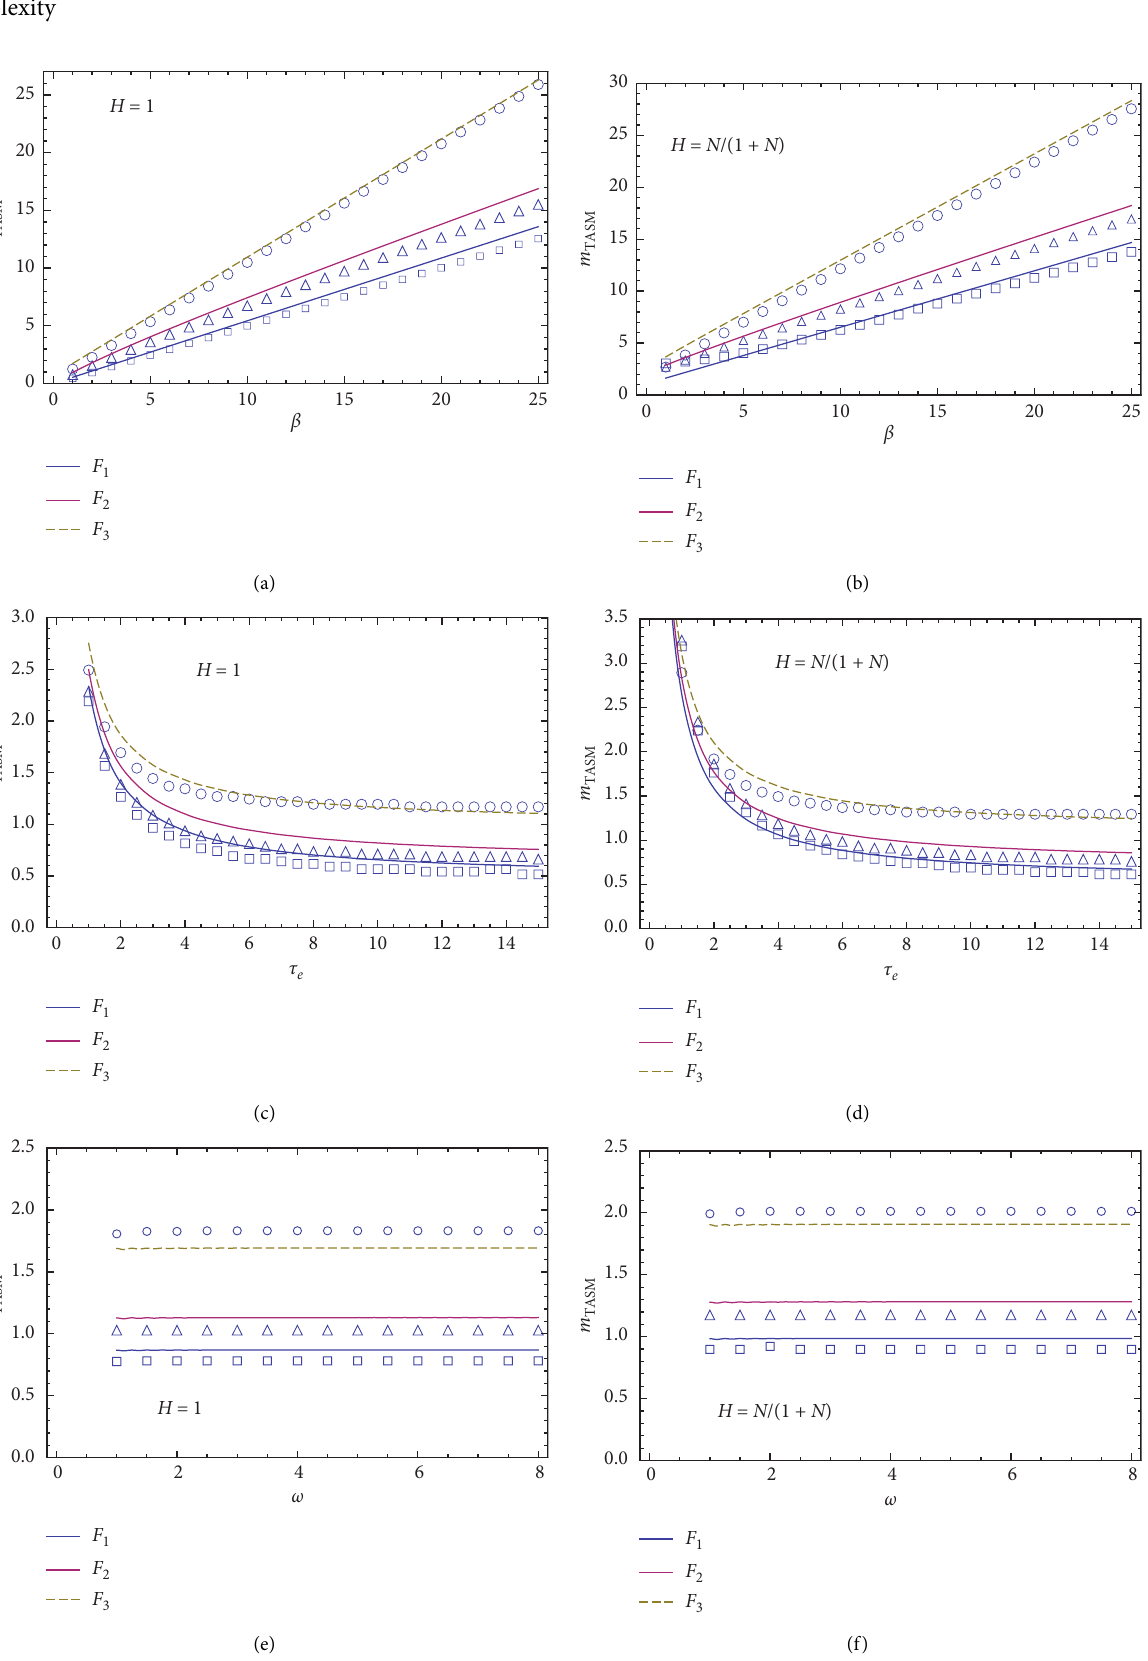
Figure 5: Theoretical and simulated m , in the case of periodic mass release strategy, as a function of β , as a function of τ e , and as a TASM function of ω . Parameters values are r � 1, ε � 0 . 5, φ � 0, α � 0 . 8, c � 0 . 5, and ( η � 0 . 18 ) . (a) Parameters values are c � 1, τ s � 0.5, τ e � 30, and ω � 1, (b) parameters values are c � 1, τ s � 0.5, τ e � 30, and ω � 1, (c) parameters values are c � 2, τ s � 4, ω � 5, and β � 15, (d) parameters values are c � 2, τ s � 4, ω � 5, and β � 15, (e) parameters values are c � 1, τ s � 5, τ e � 25, and β � 15, and (f) parameters values are c � 1, τ s � 5, τ e � 25, and β �